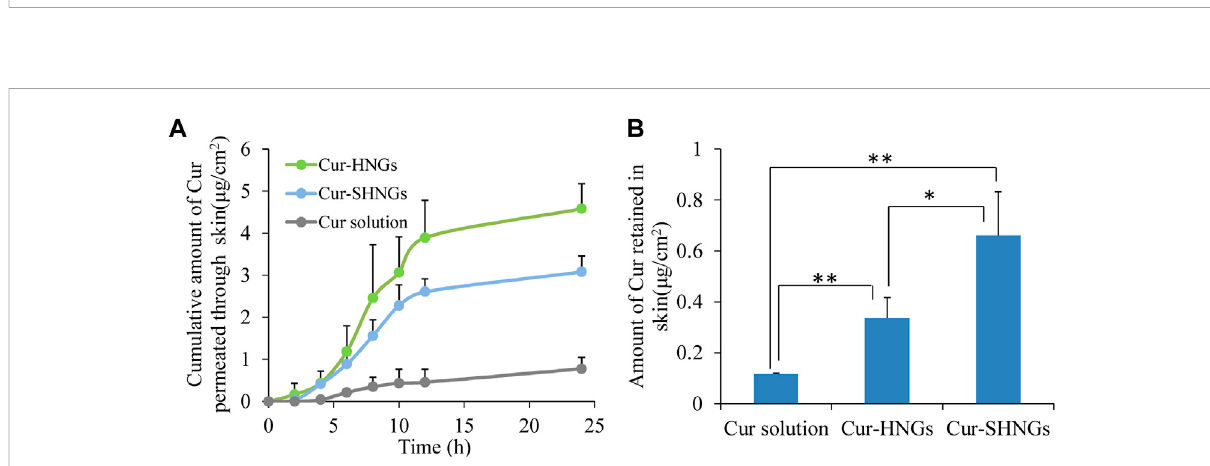
FIGURE 5 In vitro skin permeation studies of Cur solution, Cur-HNGs and Cur-SHNGs in rat skin after 24 h of topical administration. (A) The in vitro skin cumulative permeation of Cur through the skin. (B) Cur retention in the skin (results were presented as mean ± SD, n = 3; * p < 0.05, ** p <